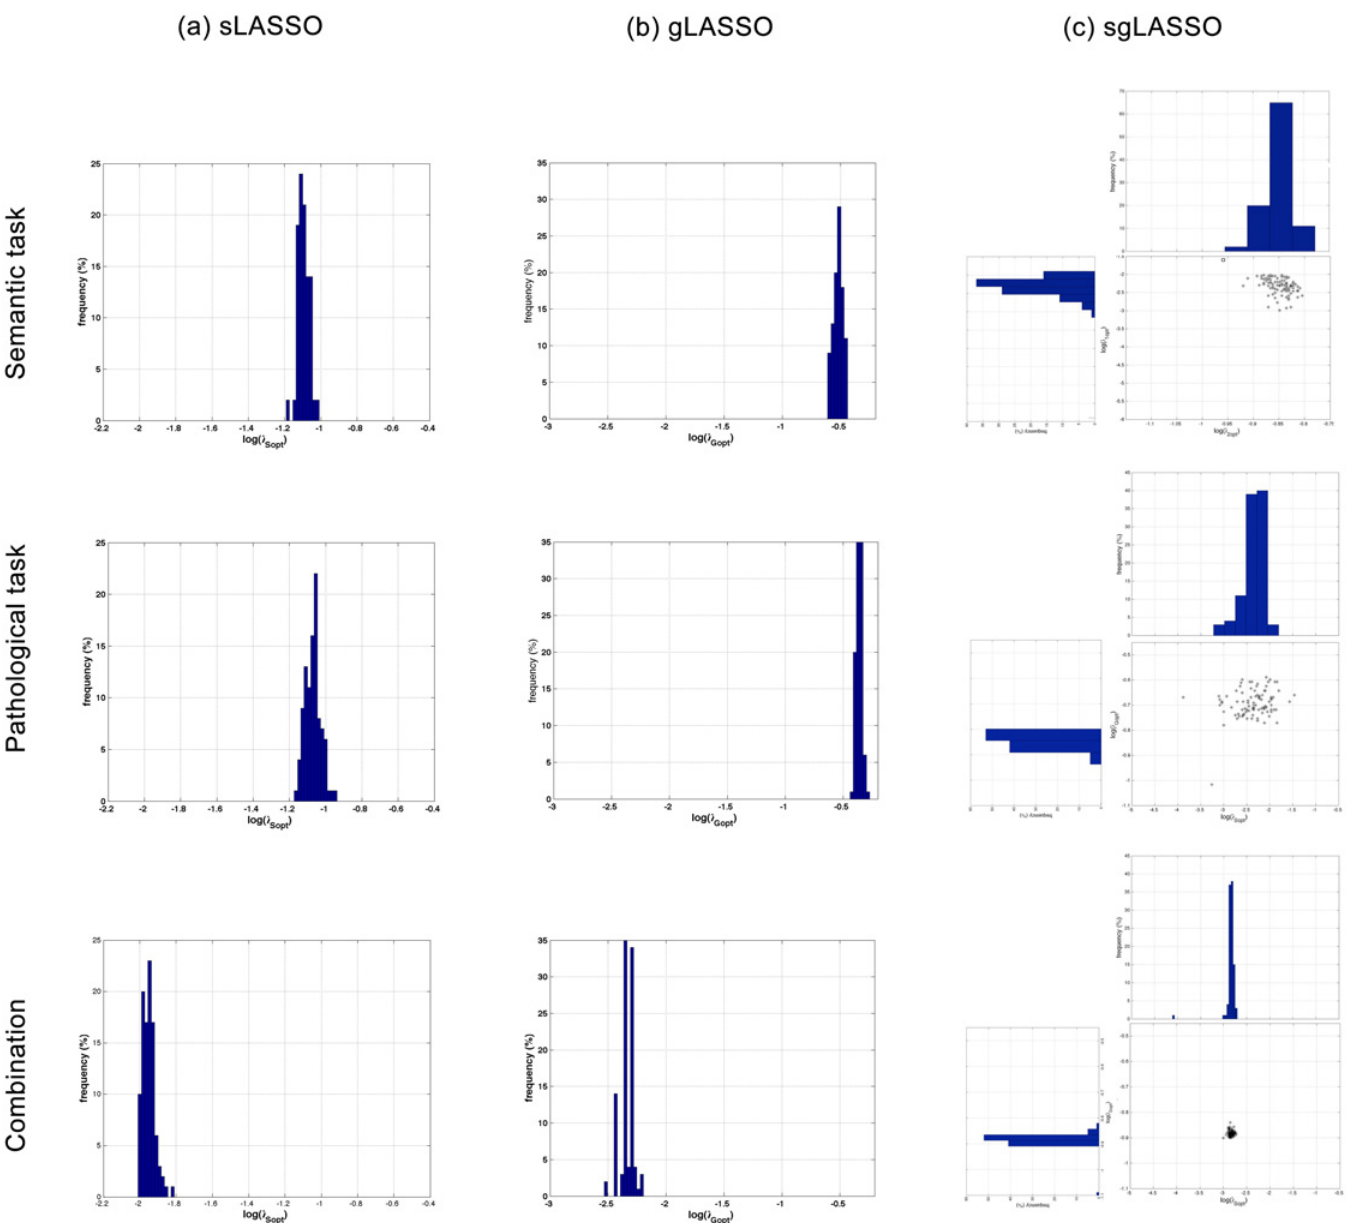
Fig 4. Histograms confirm stability of the parameters yielding the best classification performance in each cross-validation. For all datasets and algorithms, the distribution of optimal parameters over 100 nested 10-fold cross-validations shows a roughly Gaussian